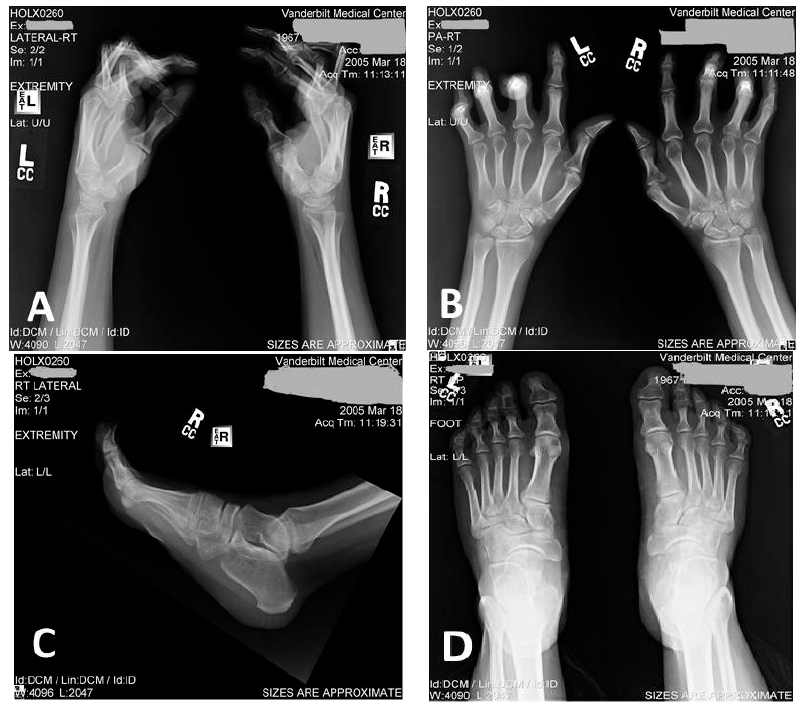
Figure 2. Radiograph of proband’s hands ( A = lateral view; B = anterio ‐ posterior (A/P view) and feet ( C = lateral R foot and D = A/P both feet).